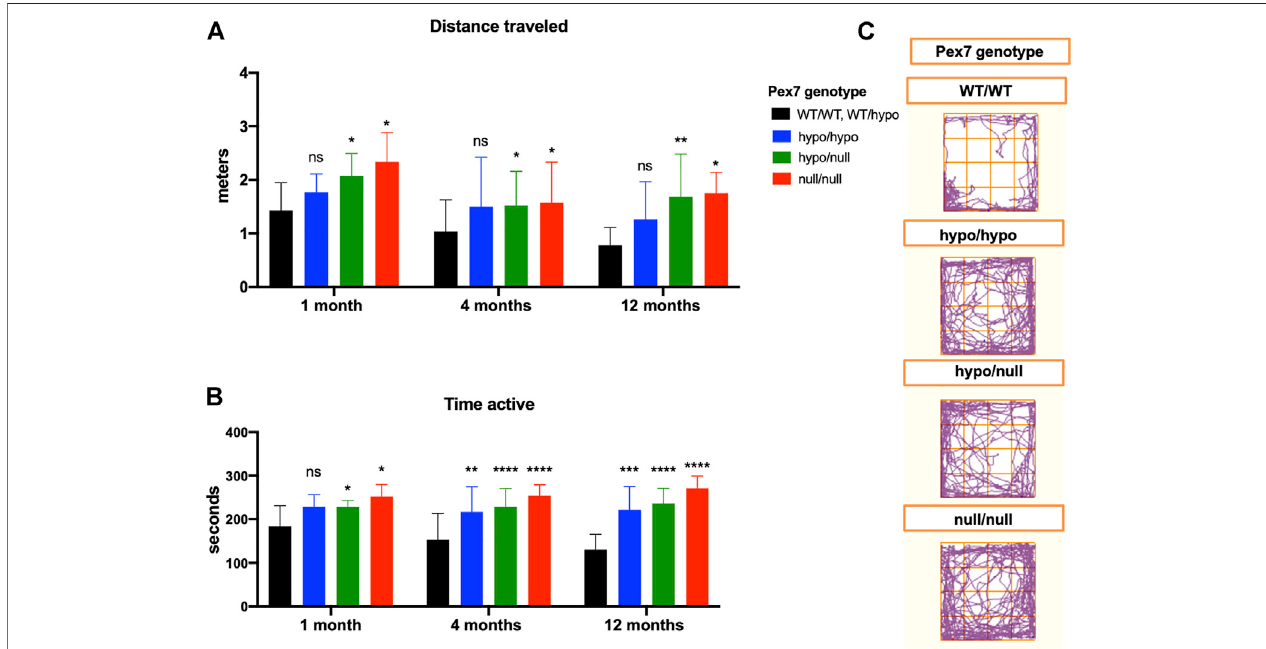
FIGURE 9 | The hyperactivity behavior of Pex7 de fi cient mice in the open fi eld environment. Pex7 de fi cient mice showed signi fi cant increase in activity levels measured by distance traveled (A) and activity time (B) at different ages in comparison to controls ( Pex7 WT/WT and Pex7 WT/hypo ). Representative images of track blots recorded during the open fi eld test of Pex7 de fi cient mice and their littermate controls (C) . Bars represent group means ± SD. ns: nonsigni fi cant, * p < 0.05, ** p < 0.01, *** p < 0.001, **** p < 0.0001 ( n = 12 – 36 per genotype).